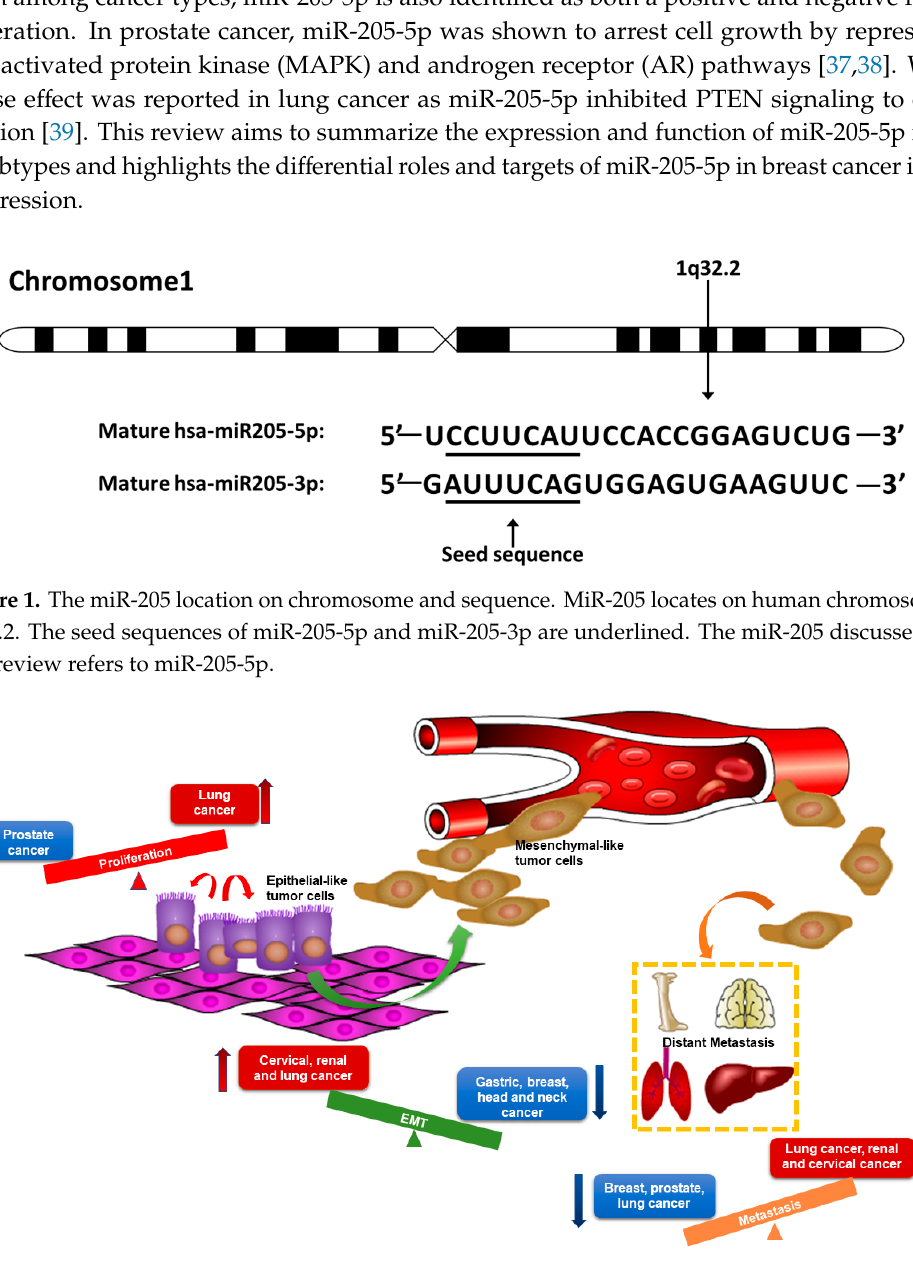
Figure 1. The miR-205 location on chromosome and sequence. MiR-205 locates on human chromosome 1q32.2. The seed sequences of miR-205-5p and miR-205-3p are underlined. The miR-205 discussed in this review refers to miR-205-5p.